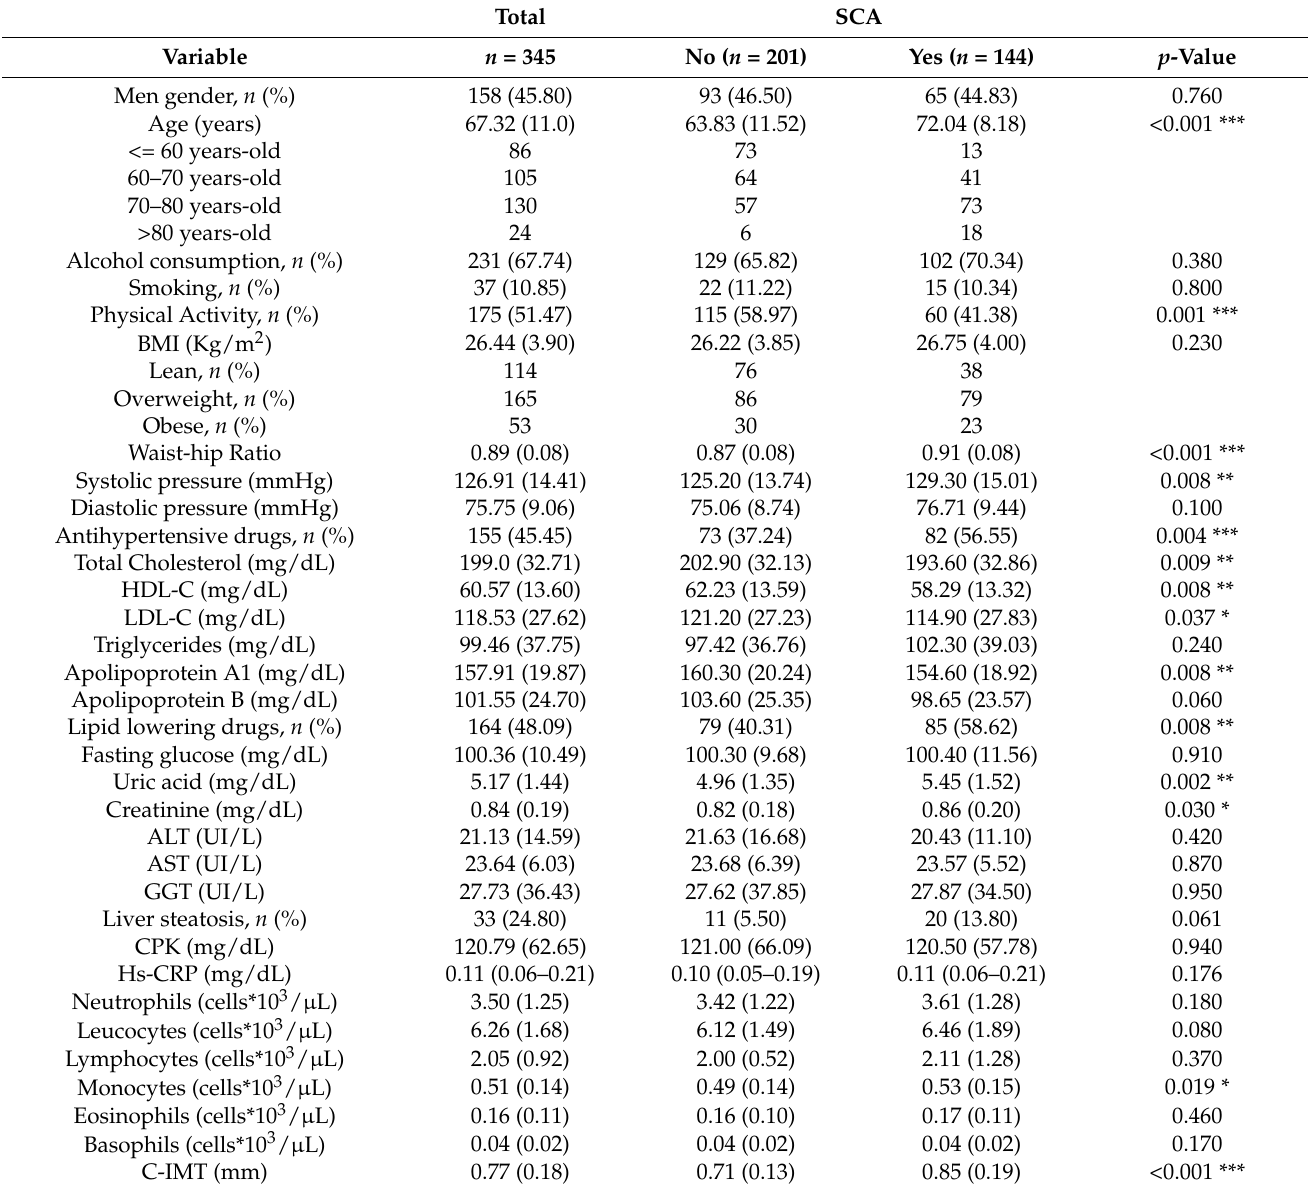
Table 1. Descriptives of the population according to